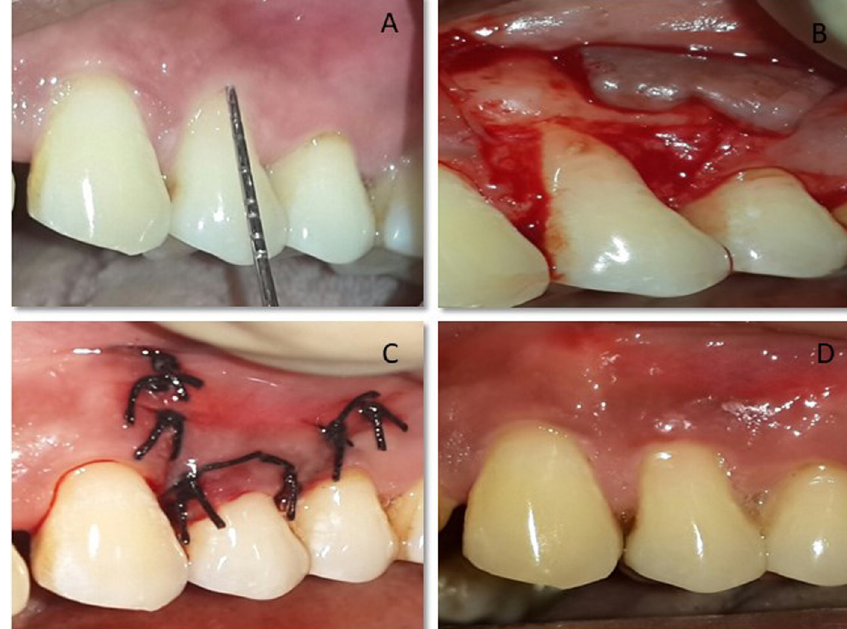
Fig. 2. Pre-surgical, surgical and post-surgical recipient site treated by CAF for Control Group, Case 2. (A) Pre-operative gingival recession defect with 24. (B) Split-full (cid:1) split thickness fl ap re fl ected. (C) CAF sutured. (D) Post-operative view at 90